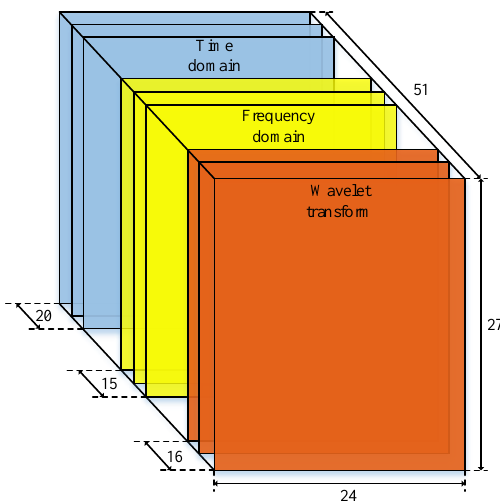
Figure 6. The 3D shallow feature map.